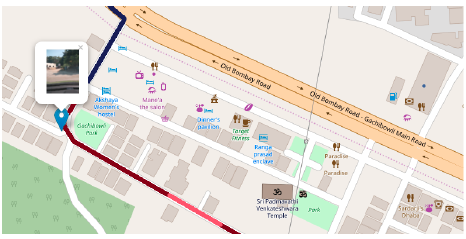
Figure 4. Gachibowli road